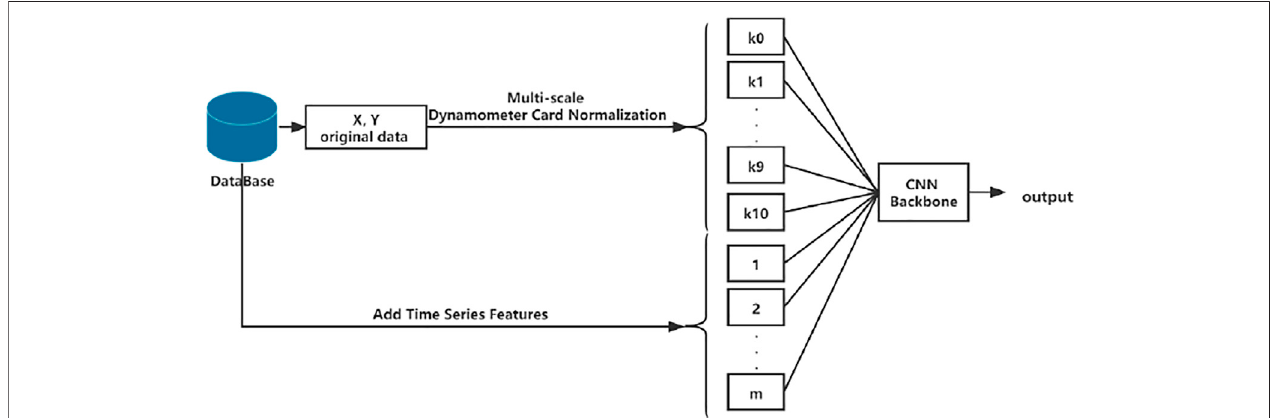
FIGURE 6 | Preprocessing method combined with the CNN architecture solution diagram.